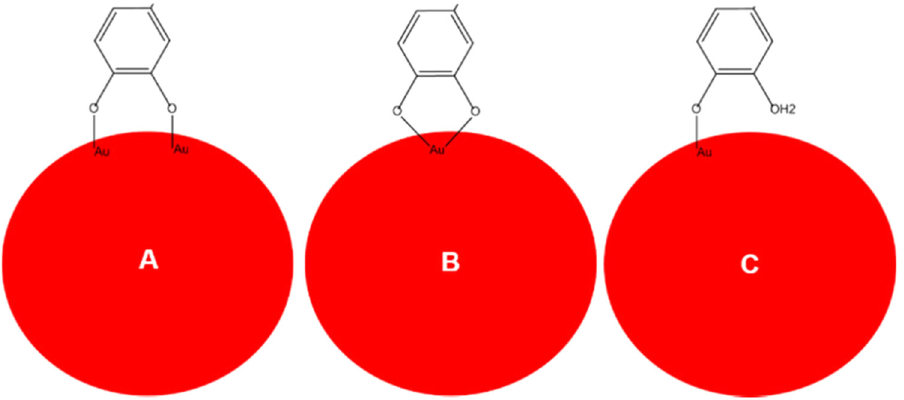
Figure 13: Schematic explanation of catechol group binding; three di ff erent con fi gurations on the surface of the MNPs. ( a ) Bidentate bridging bonding, ( b ) bidentate chelating bonding, and ( c ) monodentate ester - like bonding [ 183,184